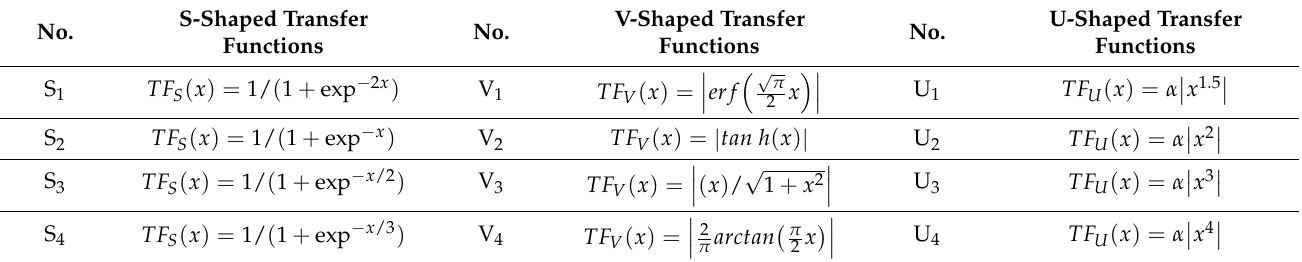
Figure 3. The S-shaped, V-shaped, and U-shaped transfer functions. Table 1. The formulation of S-shaped, V-shaped, and U-shaped family transfer